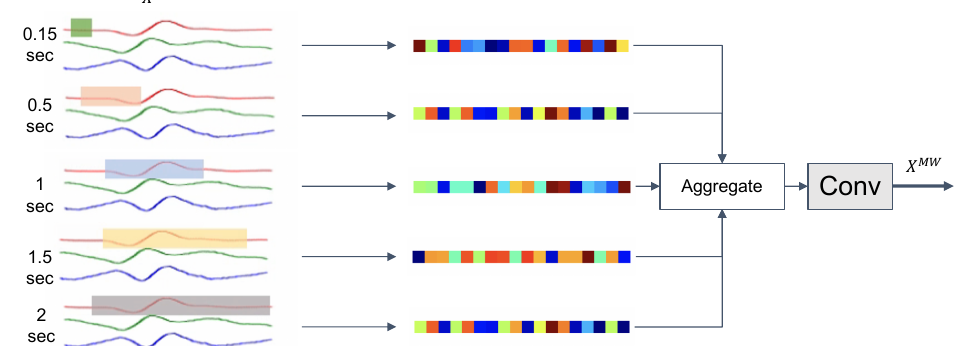
Figure 4. Multi-kernel window convolution (MW-Conv) with kernel sizes of [ 0.15,0.5,1,1.5,2 ] seconds, respectively, to capture short and long motions in human activities. We used different colors for each kernels to show that they are independent and not sharing the weights. Features from each kernel are concatenated along the feature map axis and recombined through the bottleneck layer. We have explored other feature aggregation approaches, such as summation or bilinear pooling [82], but concatenation was most effective over